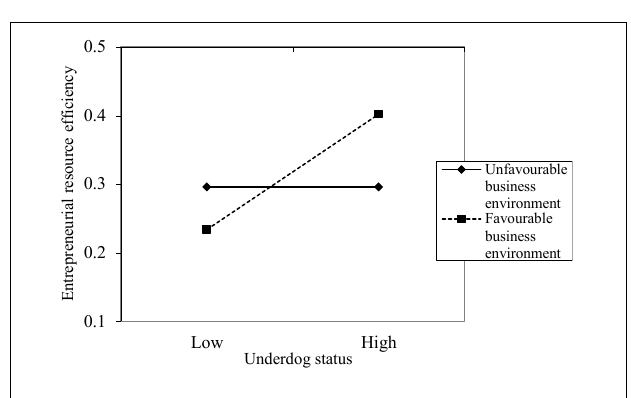
FIGURE 3 | The moderating effect of business environment on the relationship between underdog status and entrepreneurial resource efficiency.